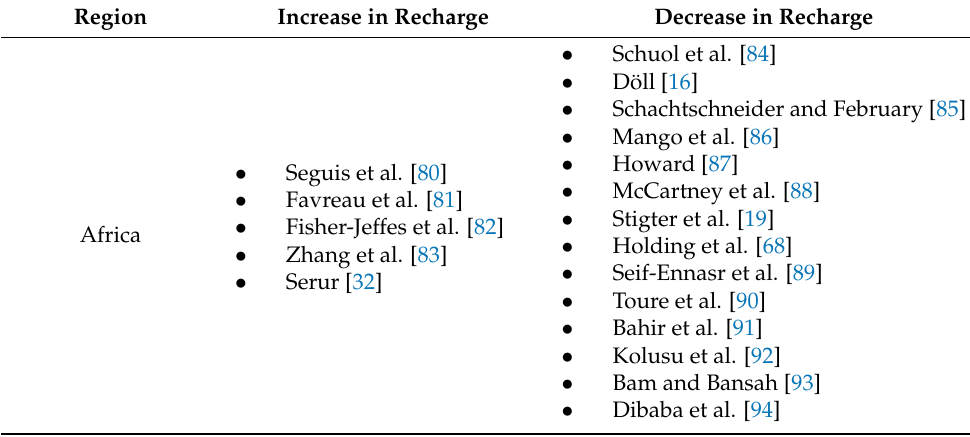
Table 3. Scientific production identified for Africa.